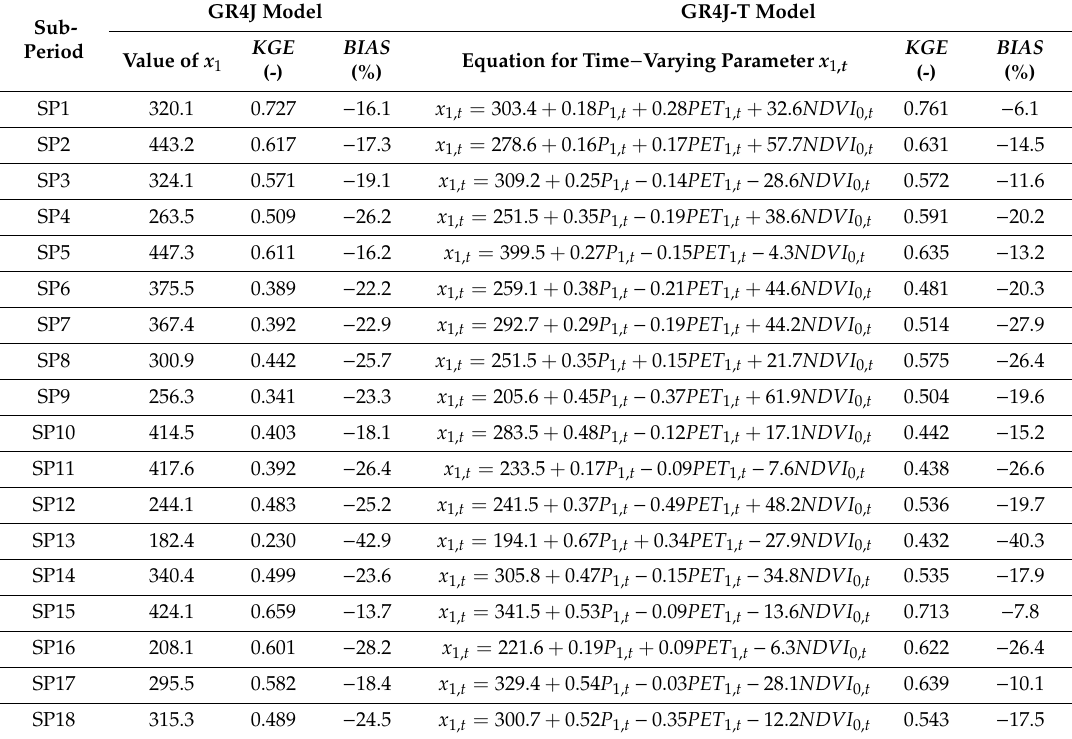
Table 5. Comparison of streamflow simulation performance of the GR4J model and the GR4J-T model in Weihe Basin for all sub-periods